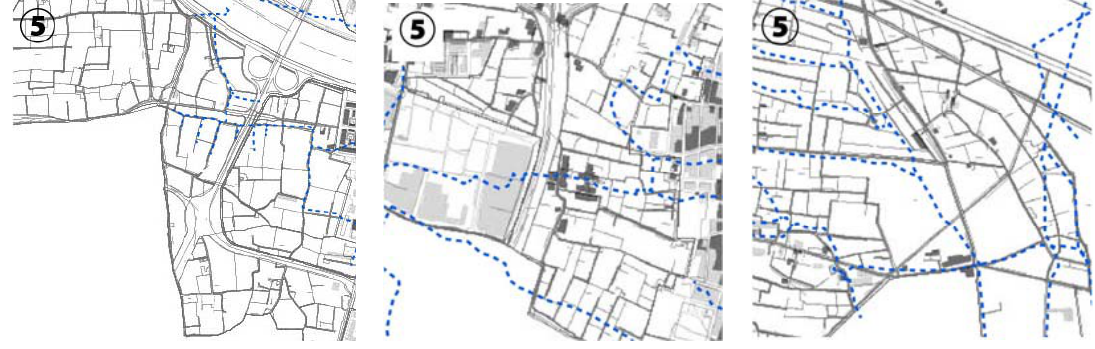
Figure 9. The transformation of the irrigation canals and the urbanization phases, along the itinerary of Acequia de Favara.